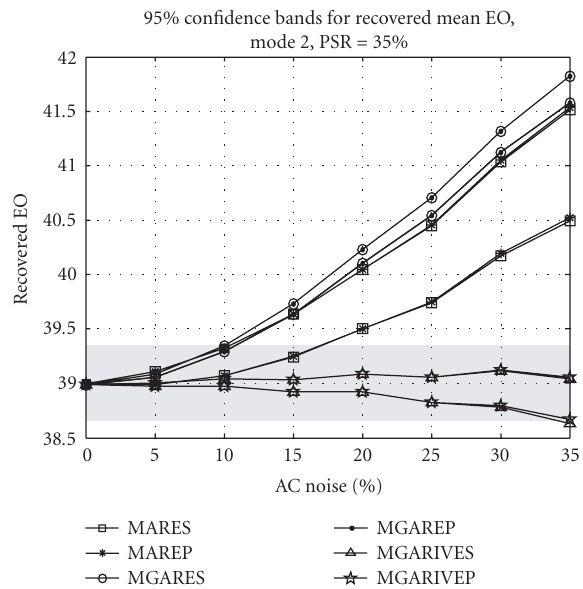
Figure 11: Test 2: 95% confidence bands for exact solution meth- ods, mode